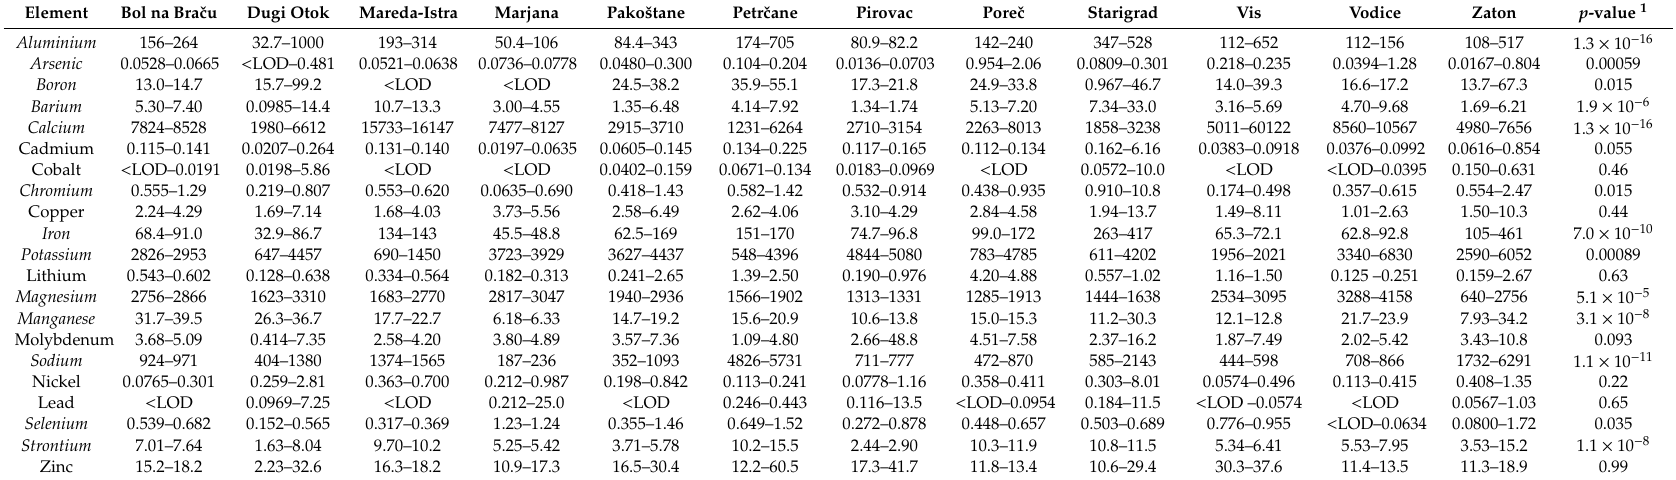
Table 3. Ranges of elemental contents in Aleppo pine needles for the individual sampling sites in mg / kg dry matter alongside p -value of ANOVA-test (elements written in italic means statistically significant di ff erence between the sampling